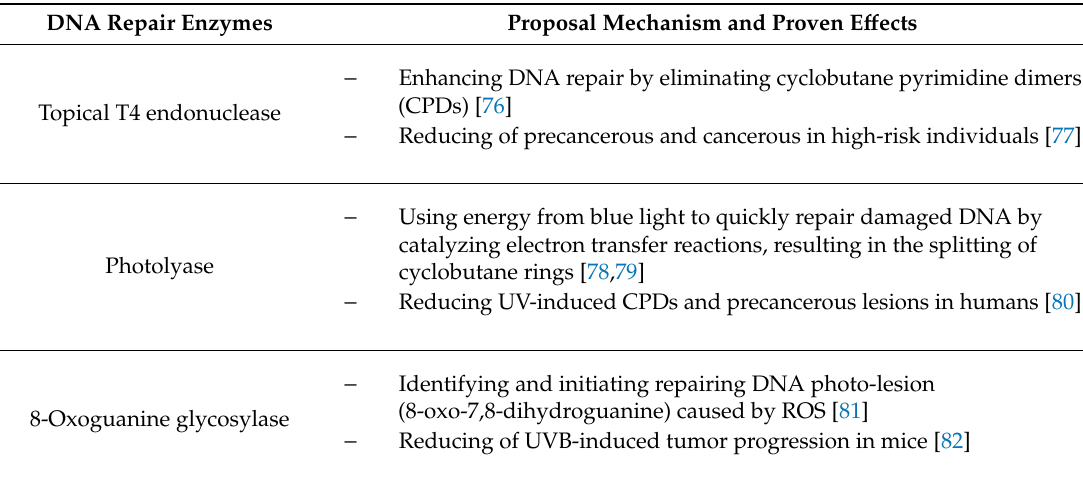
Table 2. DNA repair enzymes for skin protection